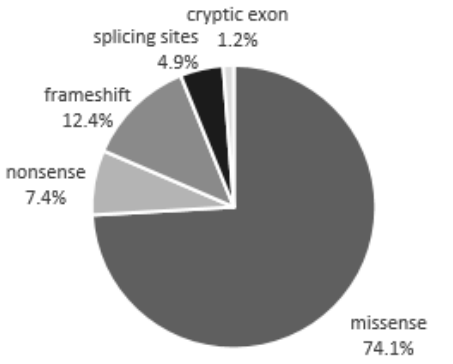
Figure 2. Classes of mutations that we found in the coding and regulatory regions of the GLA gene. 71.6% of the 81 mutations detected were found in patients who had a classic phenotype of FD (58 mutations), 19.8% (16 mutations) were found in patients with late-onset phenotype and mild